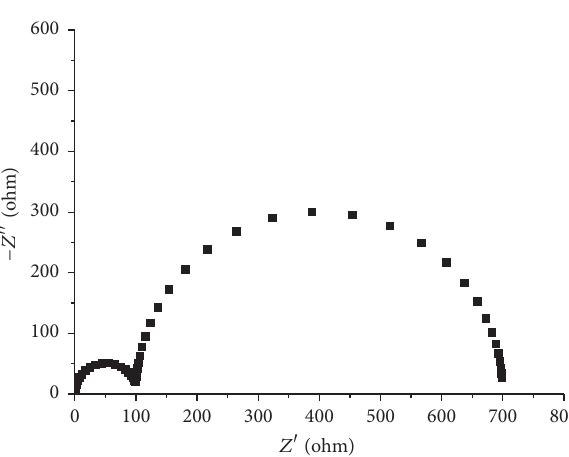
Figure 3: Nyquist plot of the equivalent circuit model shown in Figure